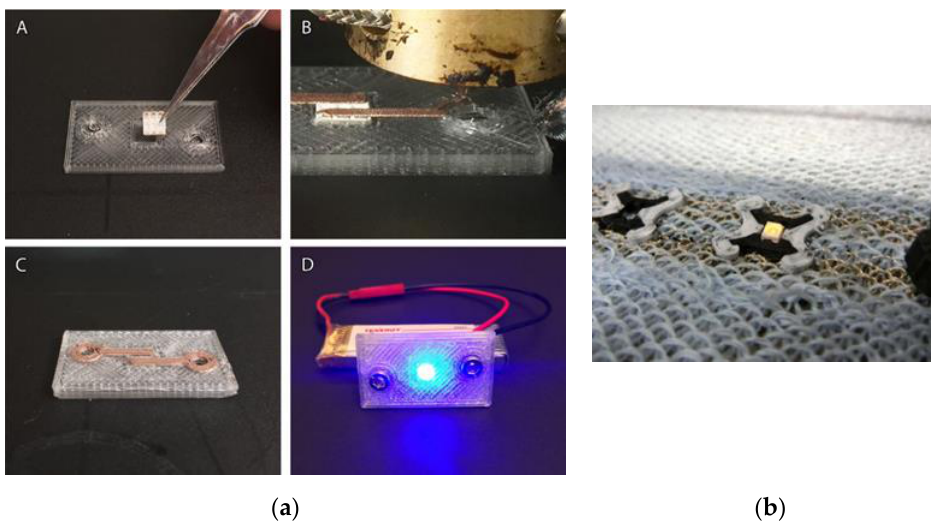
Figure 5. ( a ) Dual 3D printed circuit board (A) Inserting a LED component (B) Printing conductive traces (C) Embedded LED (D) Attached battery [30] ( b ) Dual 3D printing on textile fabric [29].